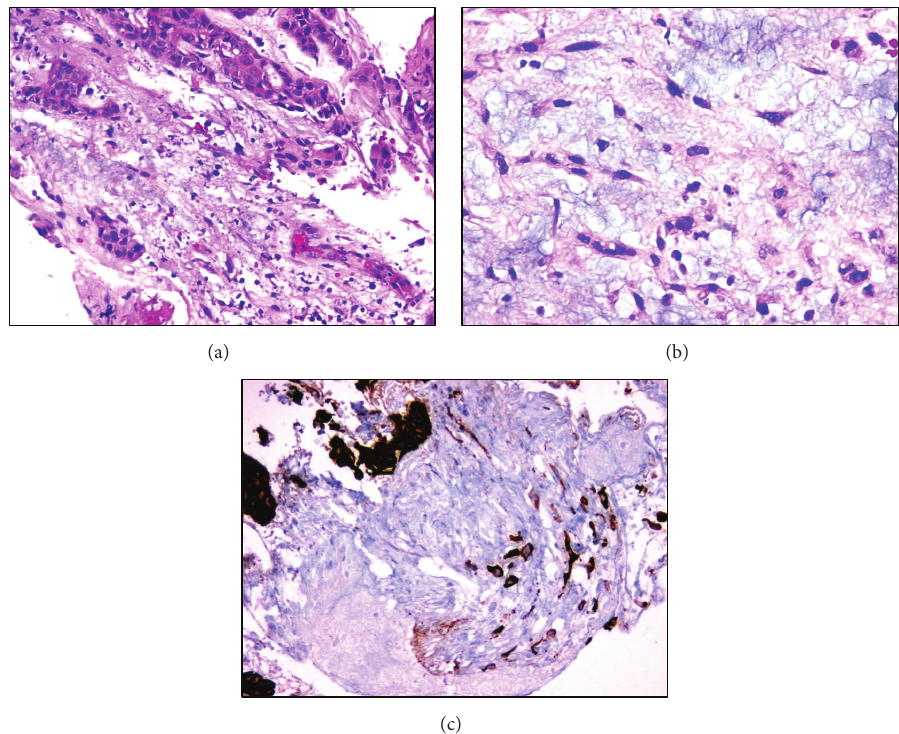
Figure 2: Microscopic appearance of atypical spindle cells and squamous cell carcinoma areas. (a) Hematoxylin and eosin (H&E), (magnification, × 20), (b) H&E (magnification, × 40), and (c) cytokeratin (magnification, ×